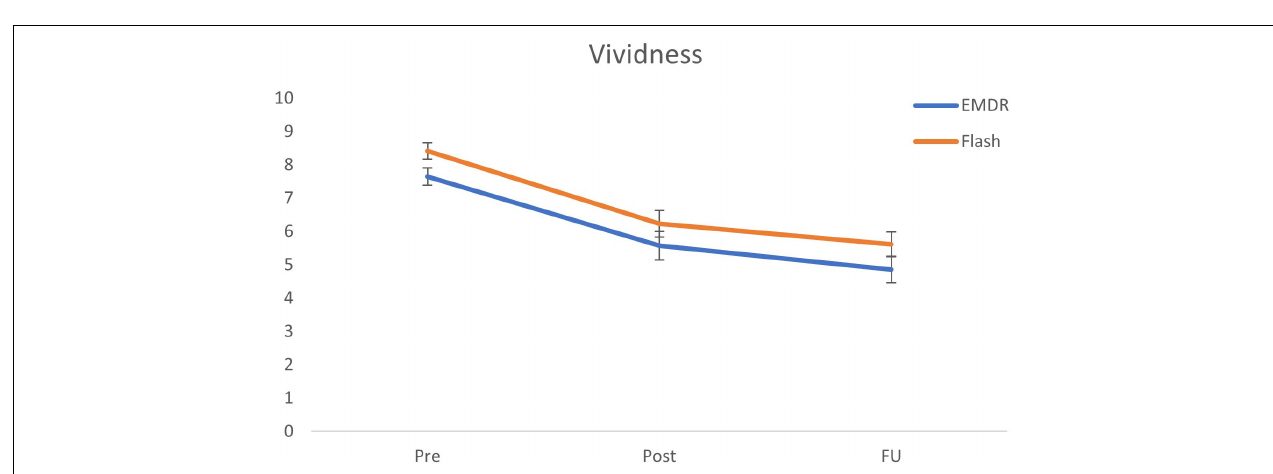
FIGURE 2 | Mean (SE) vividness scores for all time points specified per condition. EMDR = eye movement desensitization and reprocessing; and FU = follow-up after 1